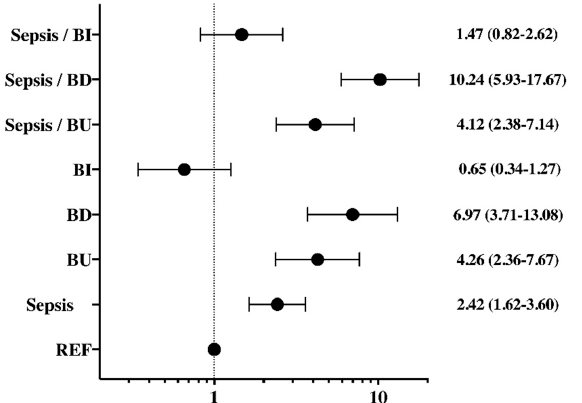
Figure 3. Adjusted risk of hospital mortality (multivariable analysis) according to the presence of sepsis and/or unchanged brain function (BU), brain function improvement (BI), or brain function deterioration (BD), using non-septic patients without brain dysfunction as reference (REF). Data are expressed as adjusted risk ratios and 95% confidence intervals.